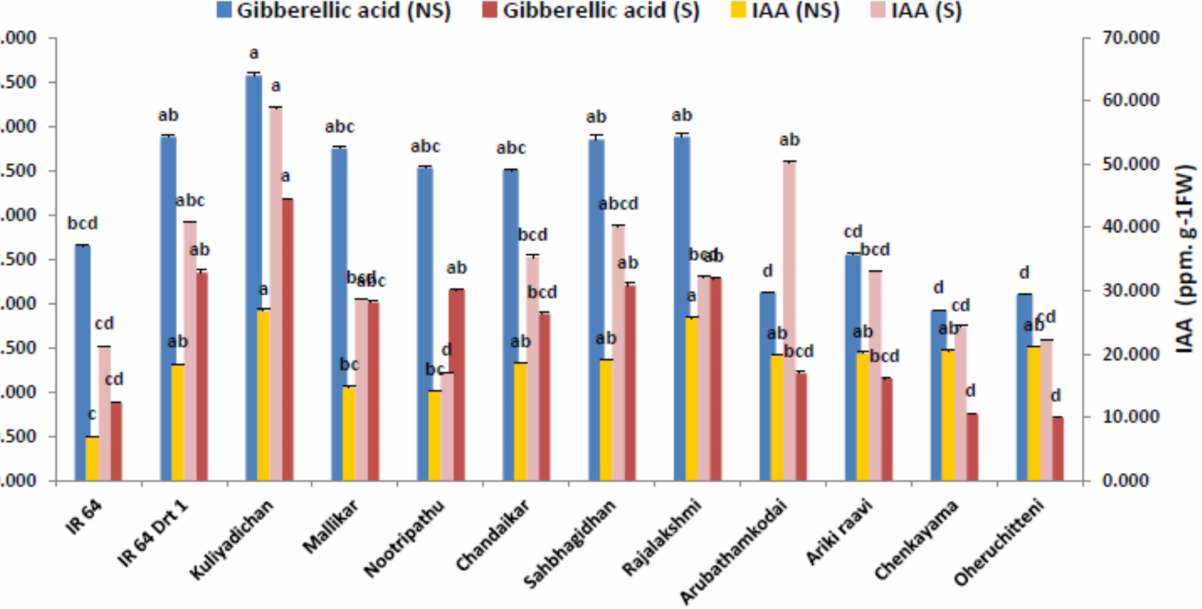
Figure 4. Influence of moisture stress on phytohormones, GA and IAA in the germinated seeds on 5 DAI in selected rice genotypes. Data represented are mean ( ± standard error) ( n = 3), and values followed by the same lowercase letter are not significantly different from each other, as determined by DMRT ( p ≤ 0.05). IR 64 and IR 64 (Drt1) used as negative and positive check, respectively, and stress imposed at − 1.5